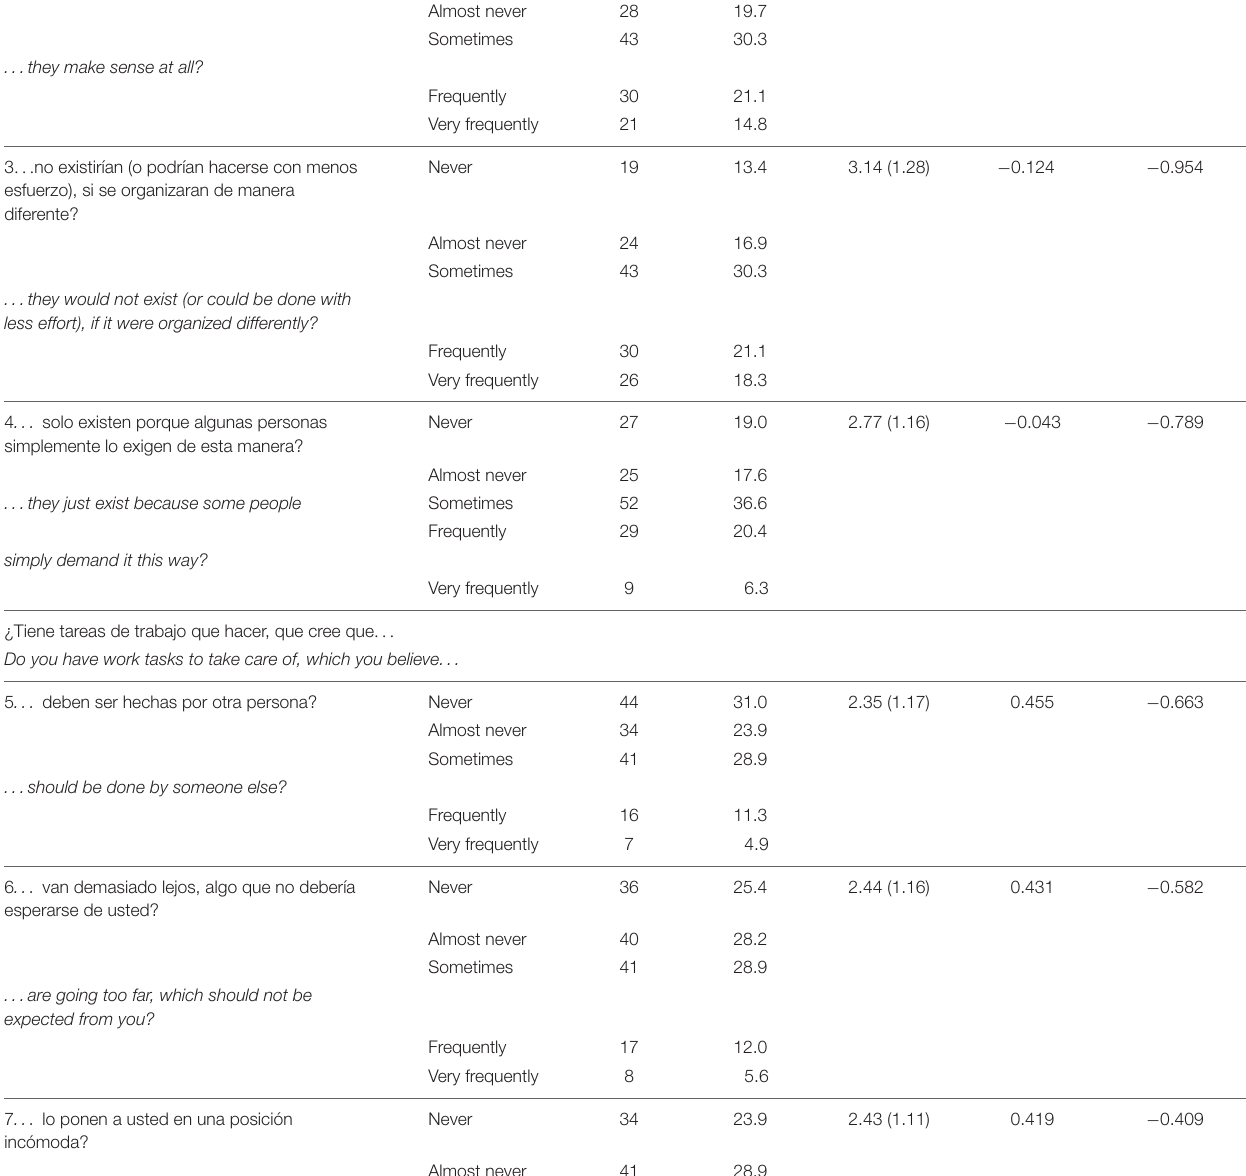
Count % de N Mean (SD) Kurtosis